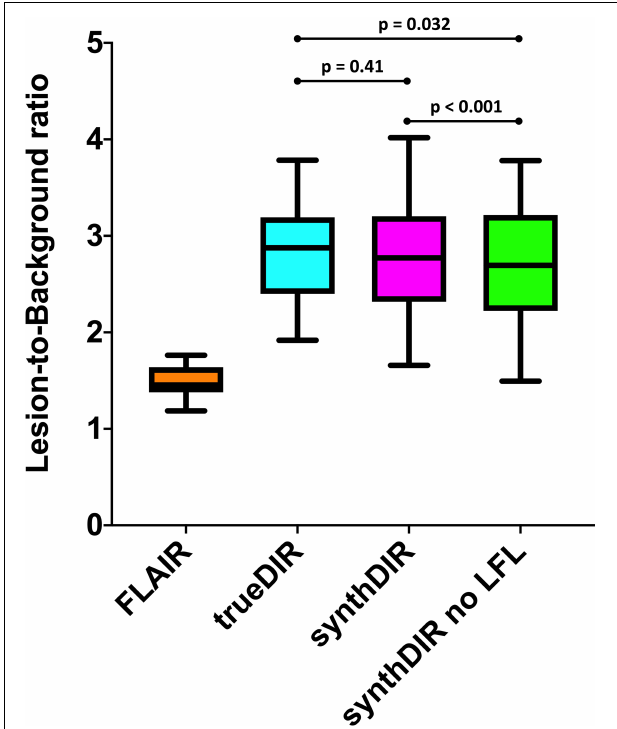
FIGURE 4 | Lesion-to-background ratios for FLAIR, trueDIR, and synthDIR. Additionally, LBR was calculated for synthDIR generated by a GAN-iteration without the lesion-focused loss (synthDIR no LFL). Of note, LBR was significantly higher in synthDIR compared to synthDIR without LFL, confirming the hypothesis that domain knowledge can be improved through LFL. While there was no significant difference in LBR between synthDIR and trueDIR ( p = 0.41), LBR of synthDIR without LFL remained inferior to the LBR of trueDIR ( p = 0.032). LBR, lesion-to-background ratio; LFL, lesion-focused